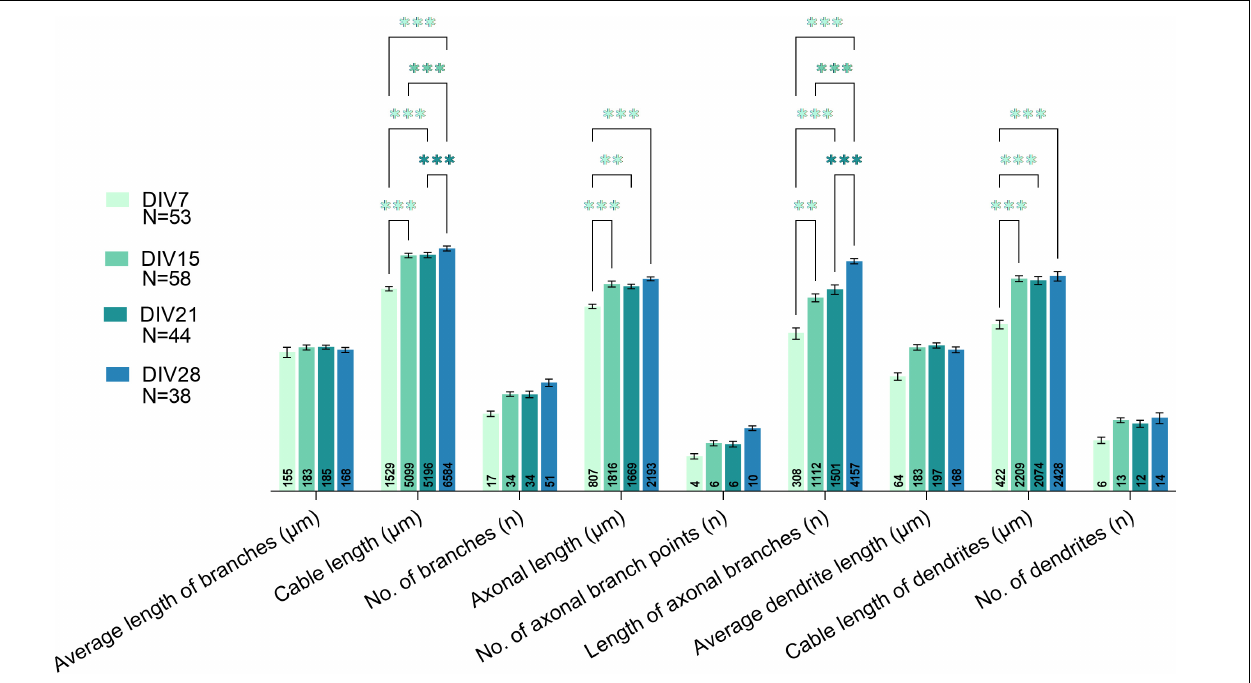
FIGURE 8 | Comparison of all studied morphological parameters between various days in vitro (DIVs). A major shift in morphological properties was observed between DIV7 and DIV15. Growth of processes was observed even in prolonged cultivation periods, as parameters related to length of processes increased significantly at DIV28. Two-way ANOVA followed by Turkey’s post hoc test was used for analyzing the difference between DIVs. Data are presented as means ± SEM, means of plotted values are annotated in each bar; ∗∗ p < 0.01, ∗∗∗ p < 0.001 of N number of cells from 3 biological replicates.